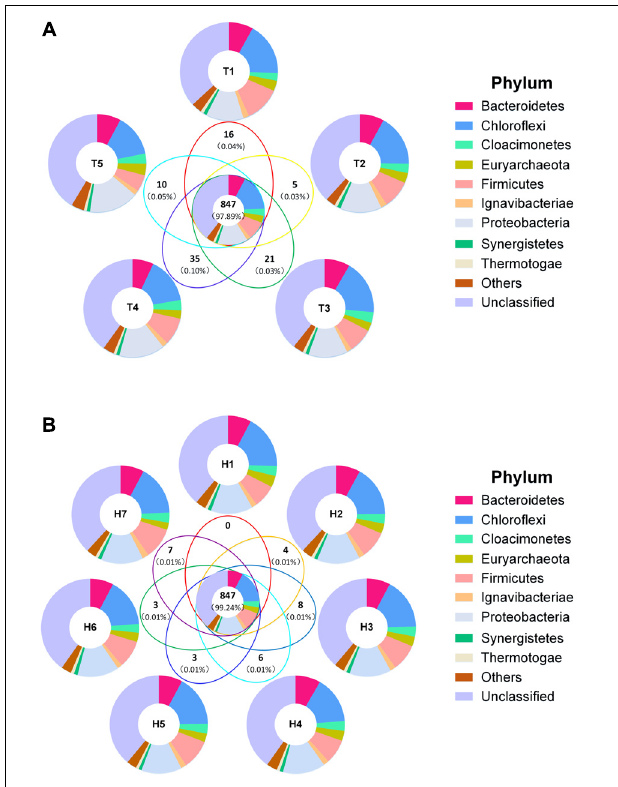
FIGURE 4 | Venn diagram of total OTUs. (A) Venn diagram of sample by time grouping. (B) Venn diagram of sample by height grouping. Bold numbers represented shared and unique OTUs numbers, numbers in brackets were average relative abundance. Different colors represented phylum distribution in corresponding